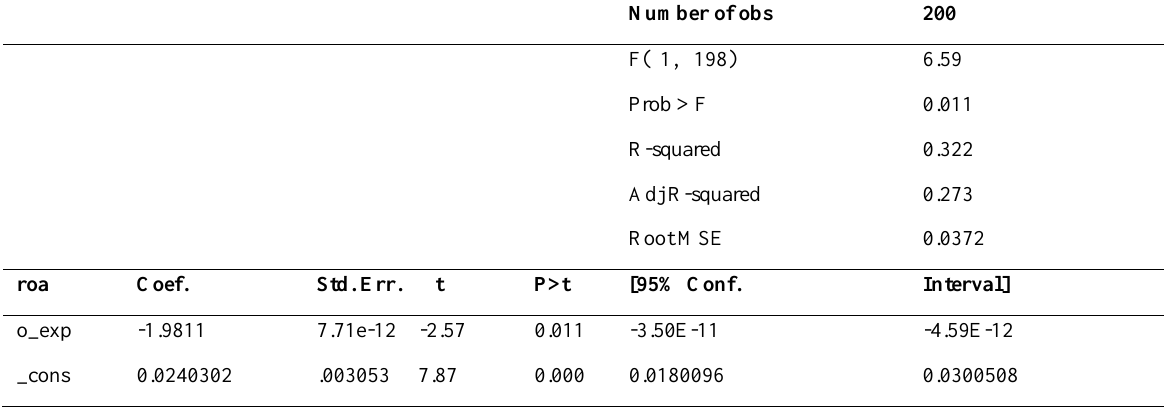
Table 1: Effect of the Operating Expense Risk Exposure on Financial